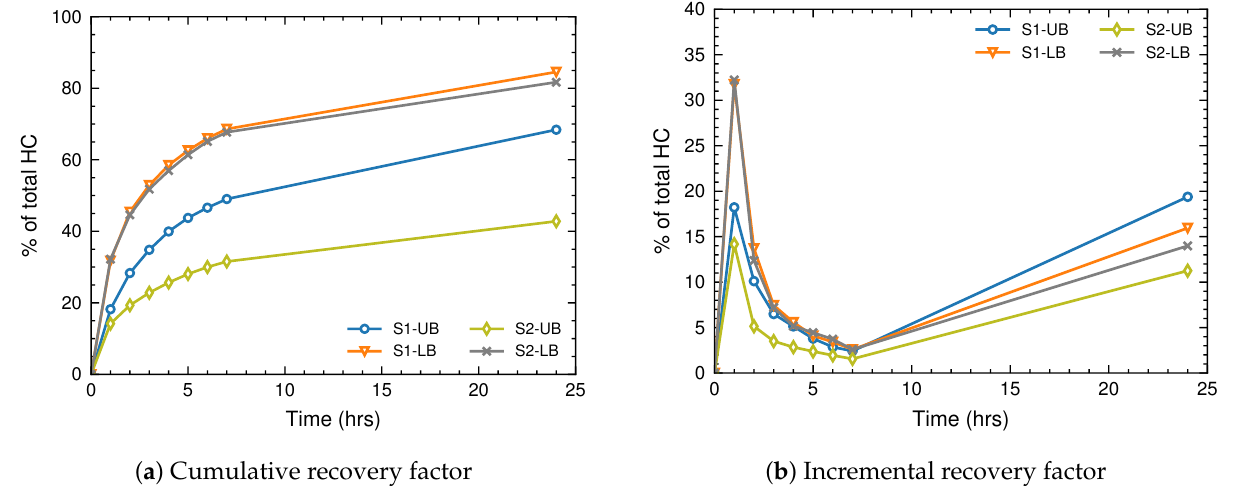
Figure 10. ( a ) The cumulative recovery factors of the shale samples over the 24-h period; ( b ) the incremental recovery factors of the shale samples over the 24-h